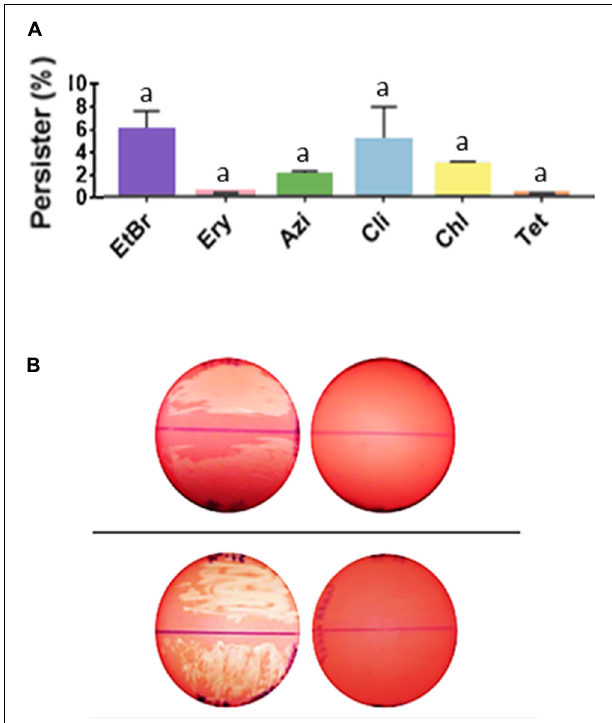
FIGURE 4 | Streptococcus pyogenes cells in biofilm-like environments show persistence to ethidium bromide and to a number of non- β -lactam antimicrobials. (A) Persisters recovered from biofilm-like environments at concentrations of 4 µ g/mL ethidium bromide (EtBr; MIC = 0.06 µ g/mL), 4 µ g/mL erythromycin (Ery; MIC = 0.12 µ g/mL), 4 µ g/mL azithromycin (Azi; MIC = 0.12 µ g/mL), 1 µ g/mL clindamycin (Cli; MIC = 0.01 µ g/mL), 16 µ g/mL chloramphenicol (Chl; MIC = 1 µ g/mL), or 16 µ g/mL tetracycline (Tet; MIC = 0.12 µ g/mL). The average CFU/mL of the control cells (no antibiotic) was 5.5 × 10 10 and corresponded to 100%. One way ANOVA was applied using CFU values ( p < 0.001; F = 24.55; DF total = 37). Post hoc Tukey’s test followed ANOVA was performed for multiple comparisons between the control and each condition ( a p < 0.001) and between the different conditions (there was no significant difference in the amount of persister cells recovered, p range = 0.995 to > 0.999). (B) Inhibition of antimicrobial persisters by the efflux pump inhibitor, cyanide 3-chlorophenylhydrazone (CCCP). Top panel ; left plate : uncovered BAB plate was supplemented with 1 µ g/mL Cli, and right plate : with 1 µ g/mL Cli and 100 µ M/mL CCCP. Bottom panel ; left plate : uncovered BAB plate was supplemented with 16 µ g/mL Chl, and right plate : with 16 µ g/mL Chl and 100 µ M/mL CCCP. Note the hemolysis that was produced by tiny (almost invisible) colonies for GAS cells in biofilm-like environments. Persisters for these antibiotics was completely inhibited in the presence of